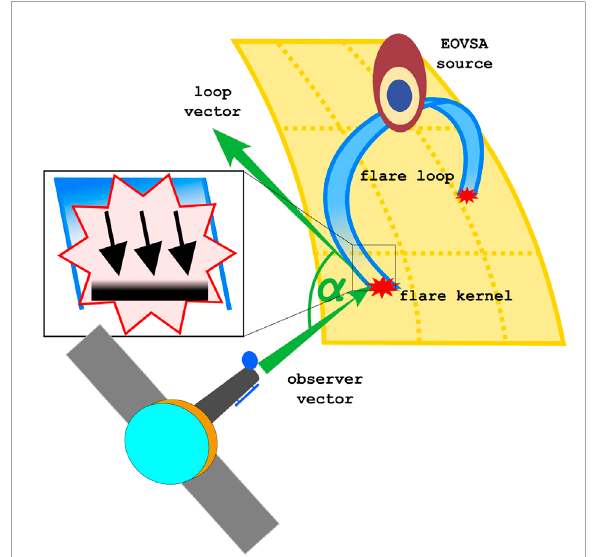
FIGURE 6 Cartoon demonstrating our definition of the angle α between the observer vector pointing along the LOS of IRIS to the flare loop footpoint (flare kernel, red star) and the loop vector directed from this footpoint to the nearest flare loop coordinate, i.e., a tangent to the loop footpoint. The zoomed inclusion on the left indicates two possible source regions of the observed spectra, one corresponding to the condensation layer (black arrows) and the other to the underlying stationary chromosphere (contoured bar). The maroon, yellow, and dark-blue contours indicate the source of the microwve emission measured by